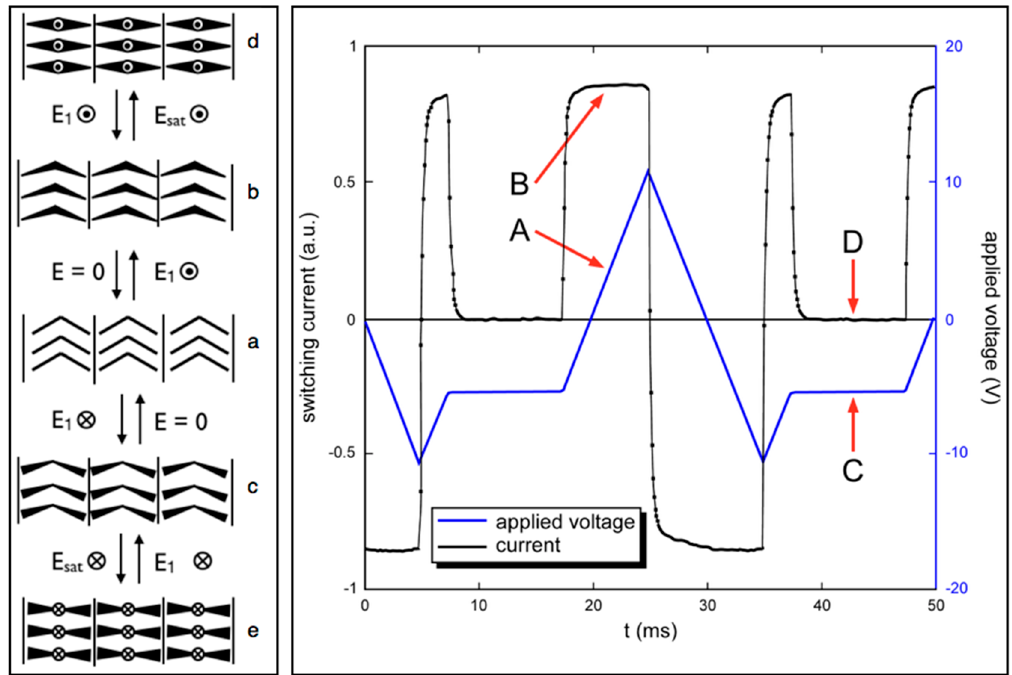
Figure 2. V-shaped electrooptic switching in the SmAP F phase. ( Left ): Cartoon showing the bent-core polar axis reorientation occurring in a bookshelf-aligned cell (substrates parallel to the page) in response to applied electric fields: ( a ) Bookshelf layer structure with P parallel to the substrates at E = 0; ( b , c ) Partial reorientation of P with applied field E 1 (sub-saturation); ( c , d ) At E sat (saturation) with P along E; ( Right ): Electrostatic V-shaped switching with optical latching–A Applied voltage (blue) changing with time, B current response (black) to voltage ramp (constant current); D No current, and essentially no energy dissipation (latching), at constant applied voltage (C).